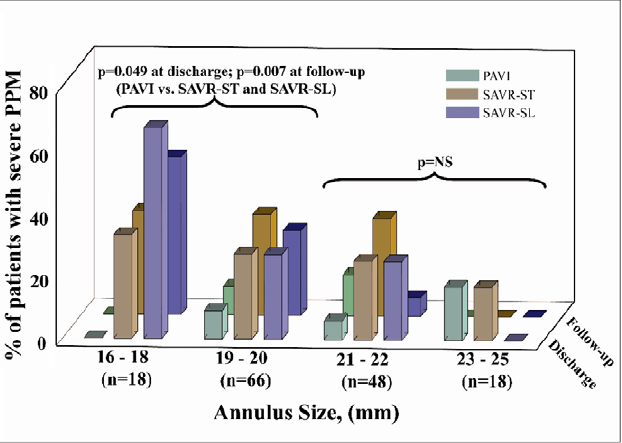
Figure. 5 Incidence of severe prosthesis-patient mismatch (PPM) in the three aortic bioprosthesis groups at hospitaldischargeandatfollow-upaccordingtotheaorticannulussize:percutaneousaorticvalveimplantation (PAVI) (green bars); surgical aortic valve replacement-stentless valve (SAVR-SL) (blue bars); and surgical aortic valve replacement-stented valve (SAVR-ST) (brown bars). (Reproduced and modified with permission from